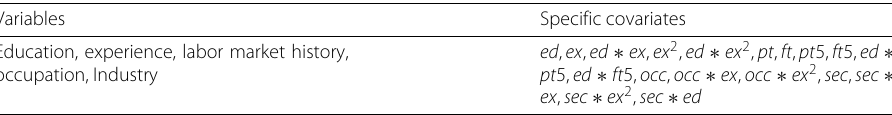
Table 9 Specification for counterfactual total employment Variables Specific covariates Education, experience, labor market history, occupation,